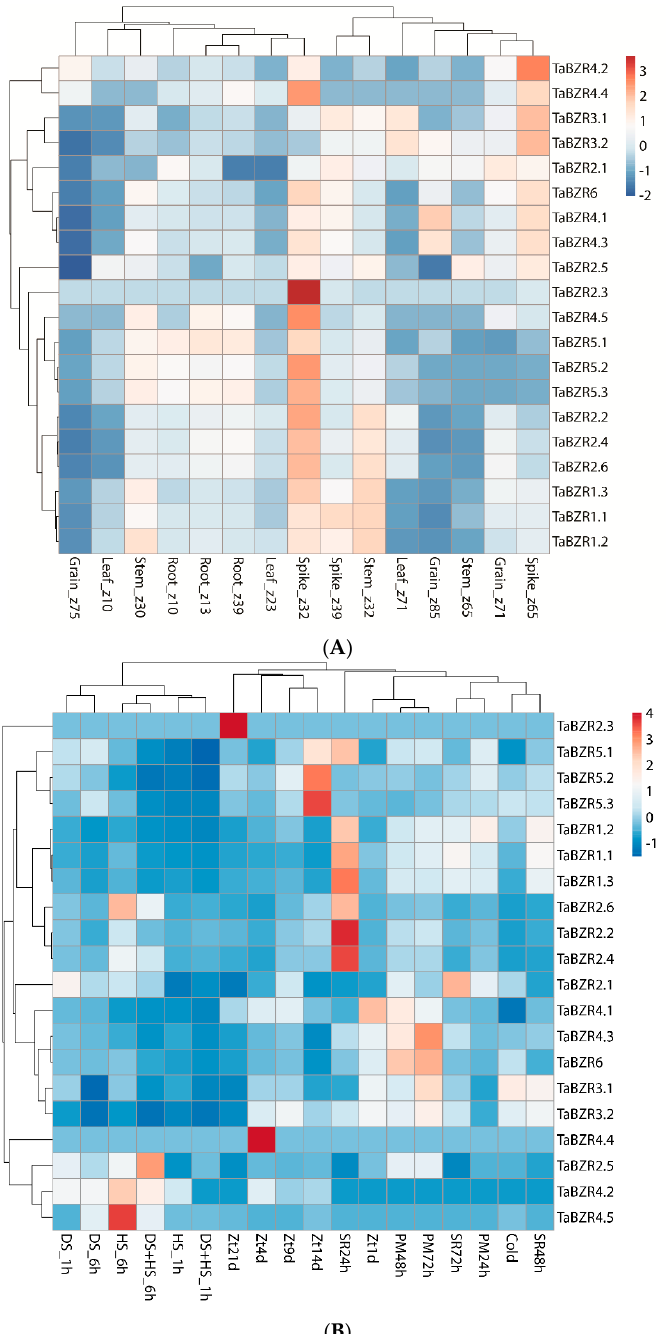
Figure 8. Heatmaps are representing the expression pattern of TaBZR genes. ( A ) In various devel- opmental stages. ( B ) In different stress conditions. TPM values were directly used to construct the heatmaps. DS: drought stress, HS: heat stress, Zt: Zymoseptoria tritici , PM: powdery mildew; SR: stripe rust, h: hour, and d: